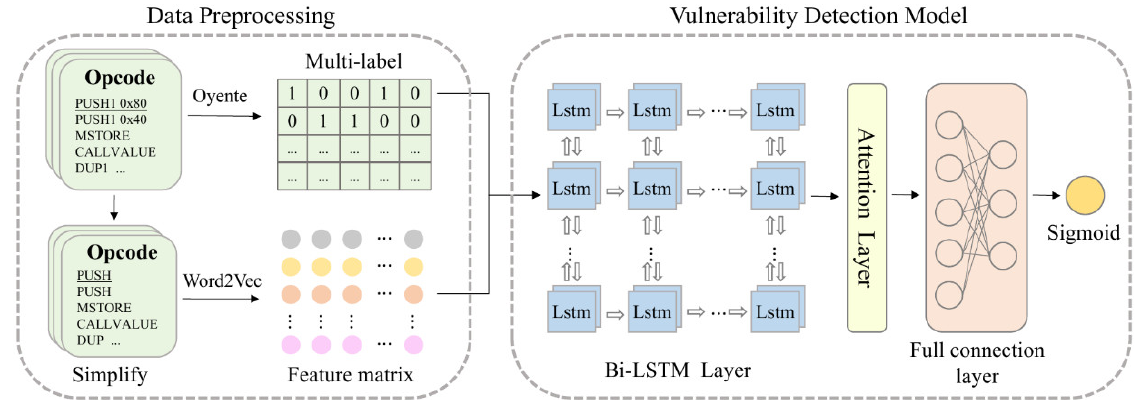
Figure 2. WBL-ATT multi-label vulnerability detection framework.